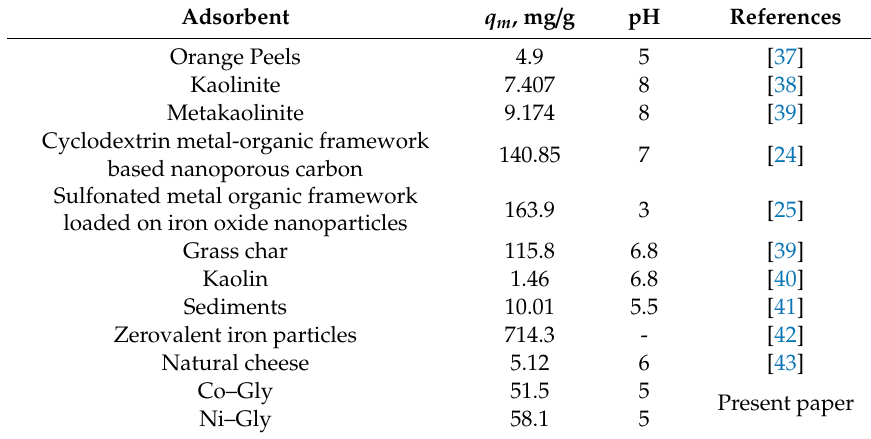
Figure 6. The adsorption performance of the studied CNs in various adsorption-desorption cycles ( a ) the adsorption capacity, after each cycle ( b ) Cd recovery, after each cycle. Table 4. Maximum adsorption capacities developed by the various adsorbent in the removal process of Cd(II) from aqueous solutions.